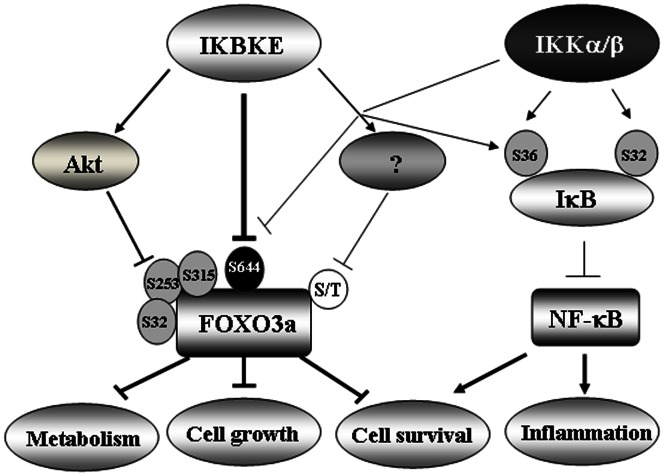
Proposed model of regulation of FOXO3a by IKBKE.IKBKE regulates FOXO3a subcellular localization, protein stability and transcription activity predominantly through direct phosphorylation of Ser644. In addition, IKBKE could modulate FOXO3a function through activation of Akt and other kinase(s).